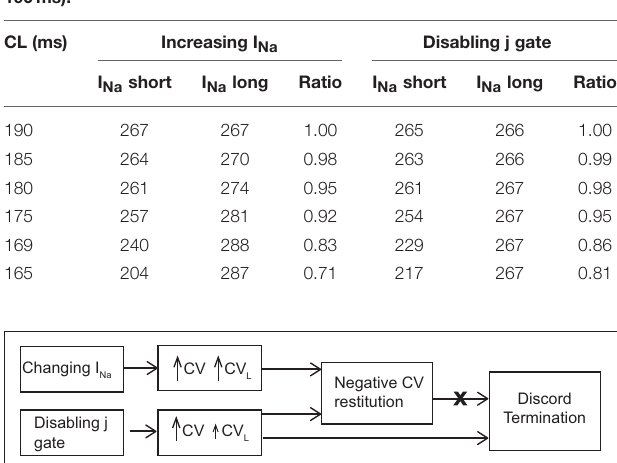
FIGURE 6 | Schematic showing the mechanistic link between SNC, generated using different methods, and discordant alternans. Note that the size of the arrows indicates the magnitude of the change in CV. For the case of disabled j gate, the increase in the CV of the short AP was more than that for the long